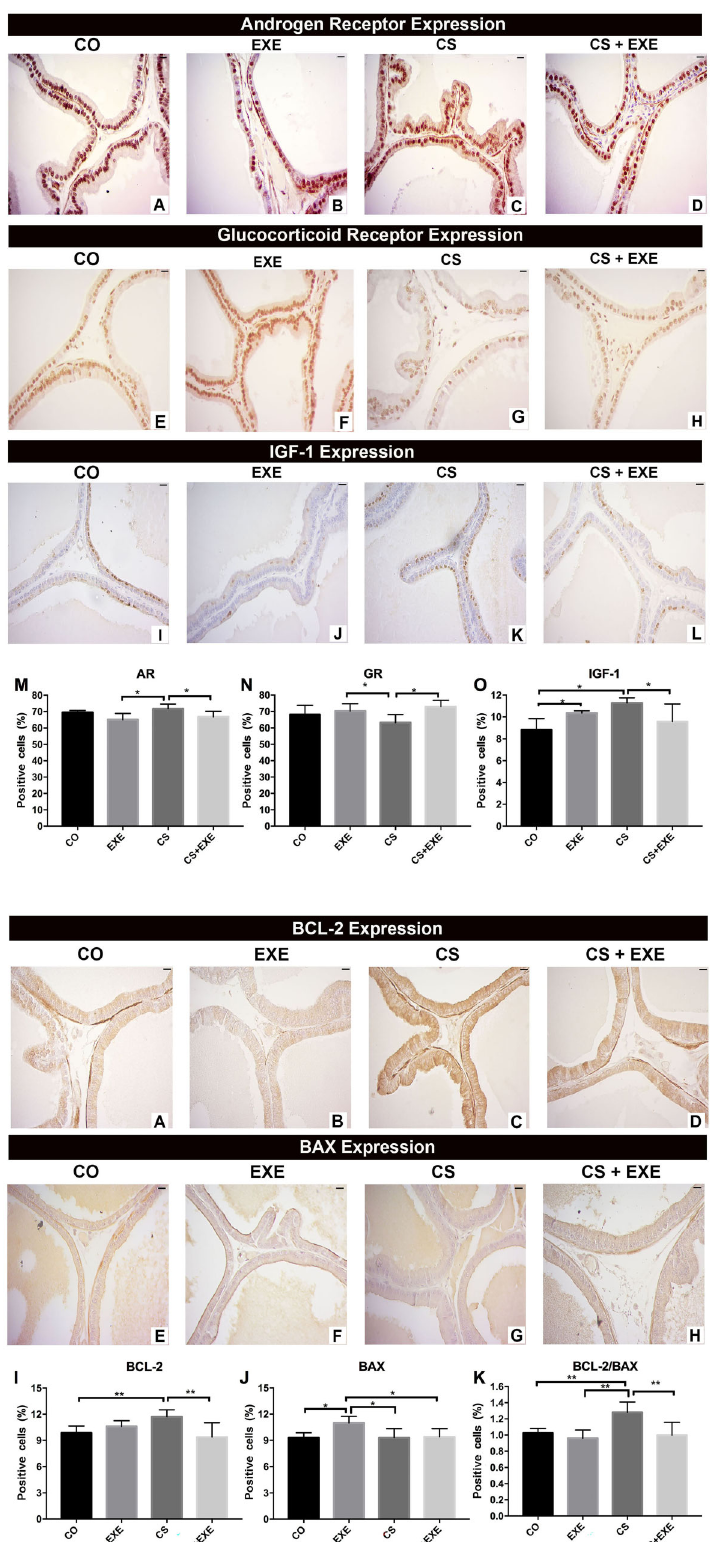
Figure 3. Distribution of the androgen receptor (AR), glucocorticoid receptors (GR), and insulin- like growth factor (IGF-1) expression evaluated by immunohistochemistry in the ventral prostate of Wistar rats submitted to cigarette smoke inhalation and aerobic exercise [control (CO) n=10; cigarette smoke inhalation (CS) n=8; exercise (EXE) n=10; cigarette smoke inhalation + exercise (CS + EXE) n=10]. AR expression is represented in images A to D and quanti fi cation of AR-positive prostate cells is shown in graph M . Representative images of GR expression are shown in images E to H and GR-positive cells are quanti fi ed in graph N . Images I to L are representative of IGF-1 expression, and the percentage of IGF-1-positive cells is shown in graph O . Scale bars, 20 m m. Data are reported as mean percentage ± SD. *P o 0.05, one-way ANOVA with Tukey ’ s multiple comparisons post hoc test.